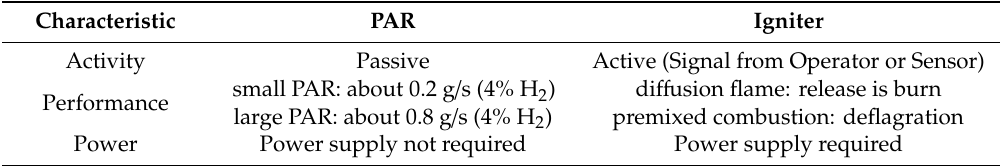
Table 1. Comparison of a passive auto-catalytic recombiner (PAR) and an